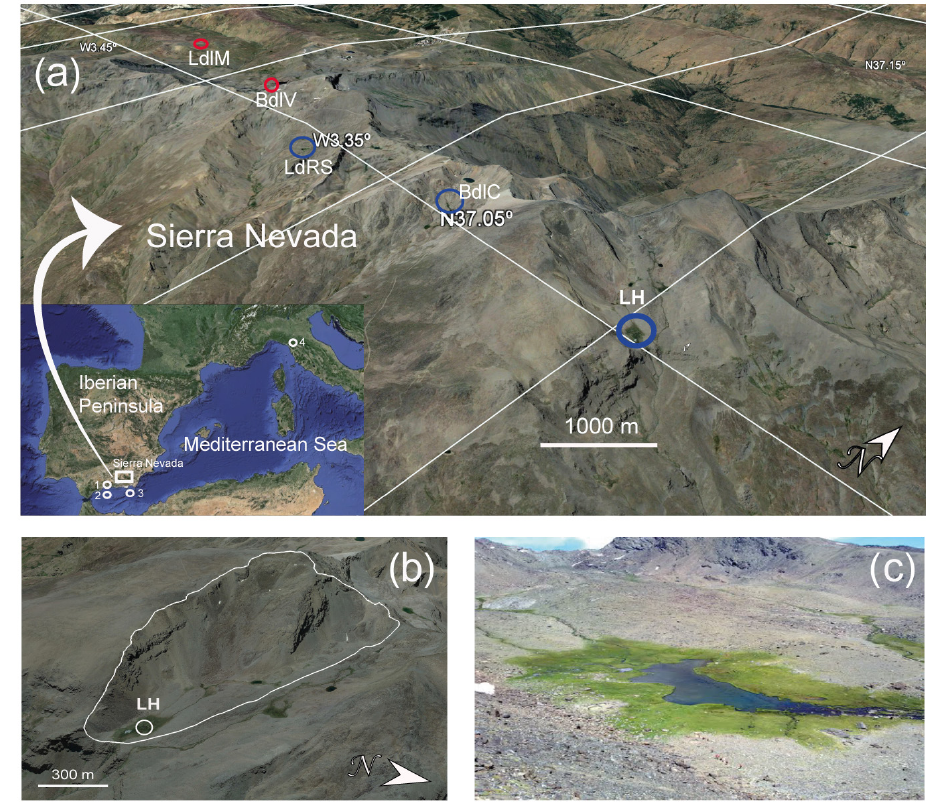
Figure 1. (a) Location of the Laguna Hondera (LH) in the Sierra Nevada, southern Iberian Peninsula, along with other nearby records mentioned in the text. (1) El Refugio Cave stalagmite record (Walczak et al., 2015); (2) ODP 976 pollen record (Combourieu-Nebout et al., 2009); (3) MD95-2043 pollen record (Fletcher and Sánchez-Goñi, 2008); (4) CC26, Corchia Cave stalagmite record (Zanchetta et al., 2007; Regattieri et al., 2014). Sierra Nevada north-facing sites are encircled in red, south-facing sites are encircled in blue. LH: Laguna Hondera, the current study, is shown in bold. LdLM: Laguna de la Mula (Jiménez-Moreno et al., 2013); BdLV: Borreguil de la Virgen (García-Alix et al., 2012; Jiménez-Moreno and Anderson, 2012); LdRS: Laguna de Río Seco (Anderson et al., 2011; García-Alix et al., 2013; Jiménez-Espejo et al., 2014); BdlC: Borreguil de la Caldera (Ramos-Román et al., 2016; García-Alix et al., 2017). (b) Regional satellite photo of LH. The white line indicates the catchment area. (c) Photo of Laguna Hondera in September 2012, when the core was taken. Photo taken by Gonzalo